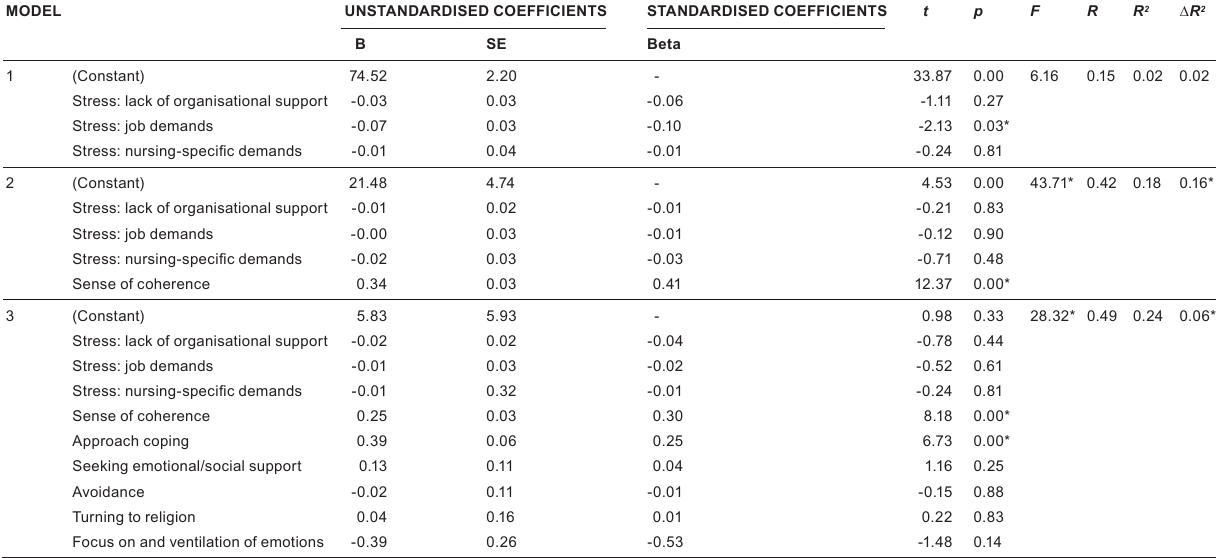
TABLE 6 Multiple regression analysis with Work Engagement as dependent variable and Occupational Stressors, Coping Strategies and Sense of Coherence as independent